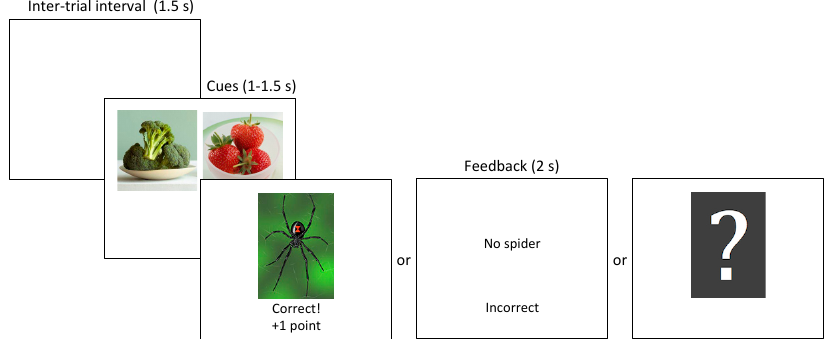
Figure 1. Trial procedure. After a 1.5-s inter-trial interval one or two food cues appeared for a fixed duration of 1 s (Experiments 1 and 2) or 1.5 s (Experiment 3). During this time participants were required to press ‘a’ or ‘l’ on the keyboard to indicate whether they thought the spider picture would follow or not. Regardless of whether they made a response, a feedback screen was shown for 2 s. On trials with feedback, the feedback screen consisted of either the picture of the spider or the words ‘No spider,’ along with the words ‘Correct! +1 point’ or ‘Incorrect.’ On trials without feedback a question mark was presented instead. On all trial types, if no response was made during cue presentation, the words ‘Press A or L faster!’ were displayed.